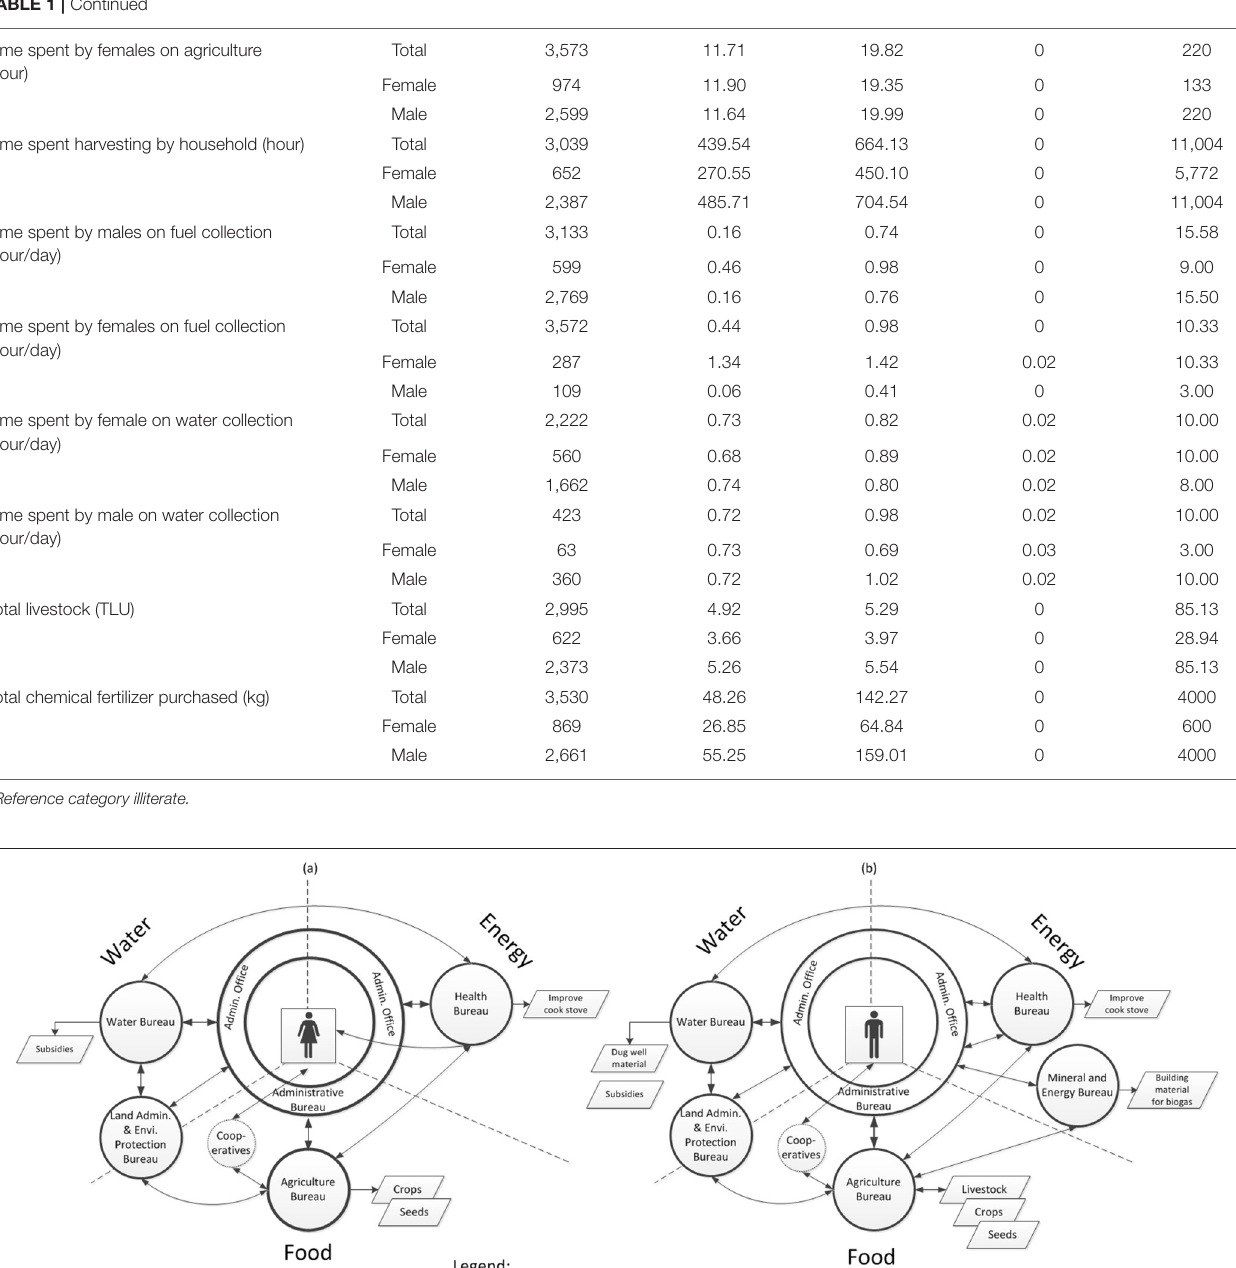
household vegetable production. Even if sufficient raw material (cattle dung) is available, it is cumbersome to compost in large amounts because it requires substantial labor for preparation and transport from pasture areas. In addition, composting cattle dung requires ∼ 50 l of water during the decomposition